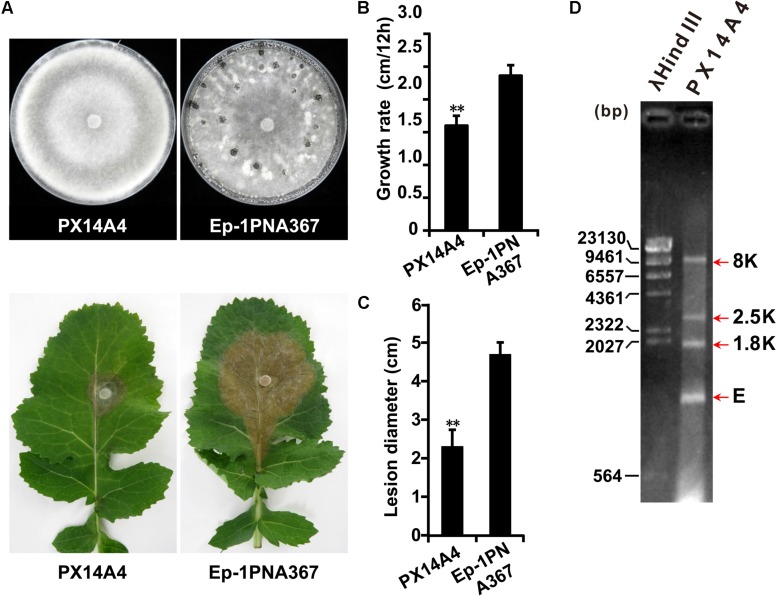
The biological characteristics and dsRNA pattern of Sclerotinia sclerotiorum strain PX14A4. (A) Colony morphology of strain PX14A4 and virulent strain Ep-1PNA367 (on PDA for 14 days at 21°C) (top). Lesion induced by strain PX14A4 or Ep-1PNA367 on detached rapeseed leaves (72 h post inoculation under 21°C) (bottom). Growth rates (B) and average lesion diameters (C) of strains PX14A4 and Ep-1PNA367. “**” indicates a significant difference (p < 0.01) between strain PX14A4 and Ep-1PNA367. (D) Agarose gel electrophoresis analysis of the dsRNA extracted from strain PX14A4. The dsRNA was treated with DNase I and S1 nuclease prior to electrophoresis. The dsRNA was named 8K, 2.5K, 1.8K, and E. Size of the DNA ladder standard is indicated in base pair (bp). M, molecular weight marker (Takara).